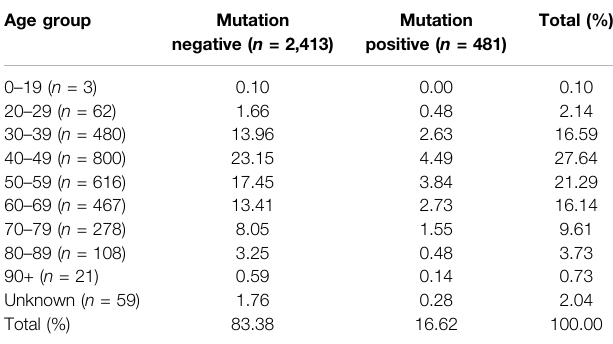
TABLE2| Comparisonbetweenthenumberofmutation-positiveversusmutation- negative patients (re fl ected in percentages) observed per ten-year intervals. Age group Mutation Mutation Total negative ( n = 2,413) positive ( n = 481)